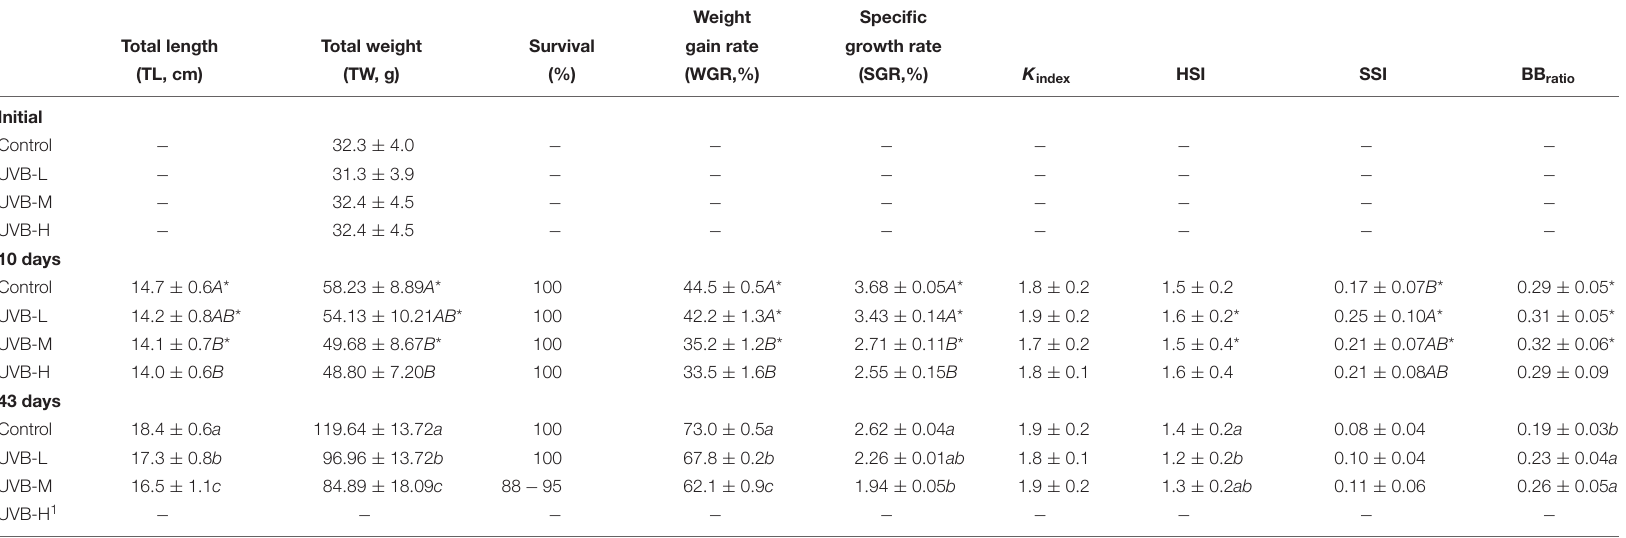
TABLE 2 | Total length (TL, cm) and total weight (TW, g), survival (%), weight gain rate (WGR,%), specific growth rate (SGR, %), Fulton’s condition index (K index ), hepatosomatic index (HSI), splenosomatic index (SSI) and brain-to-body mass ratio (BBratio) in S. aurata after 10 and 43 days of exposure to UVB (mean ± SD; n = 30).